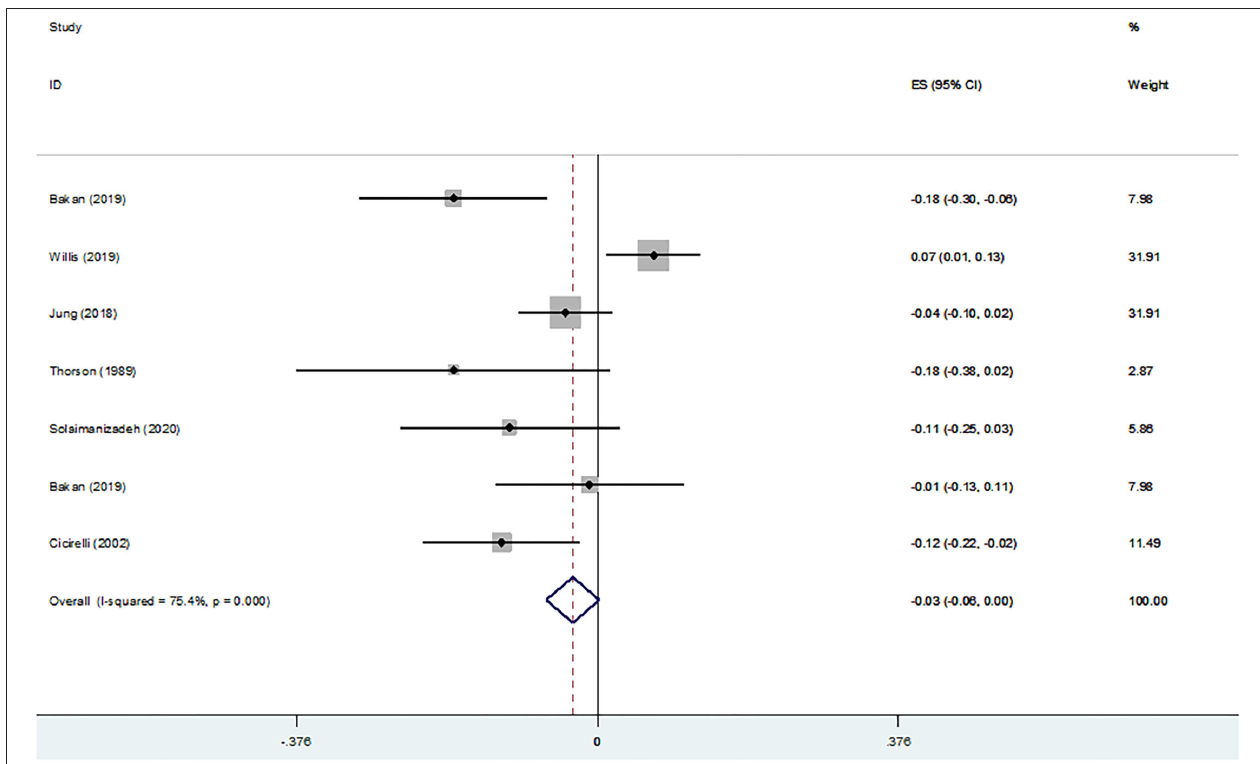
FIGURE 3 | Z-scores for death